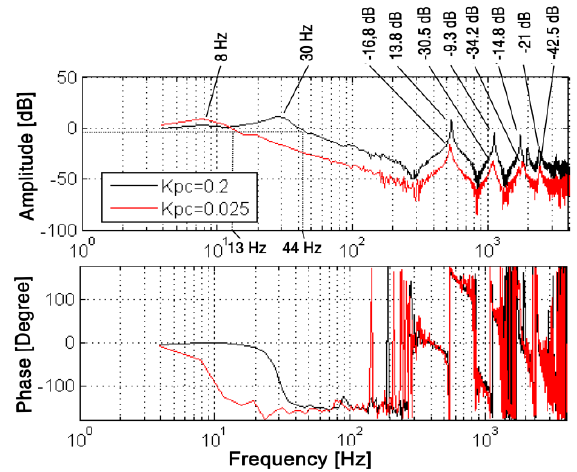
Fig. 3. The influence of the gain of the speed loop on its frequency response.